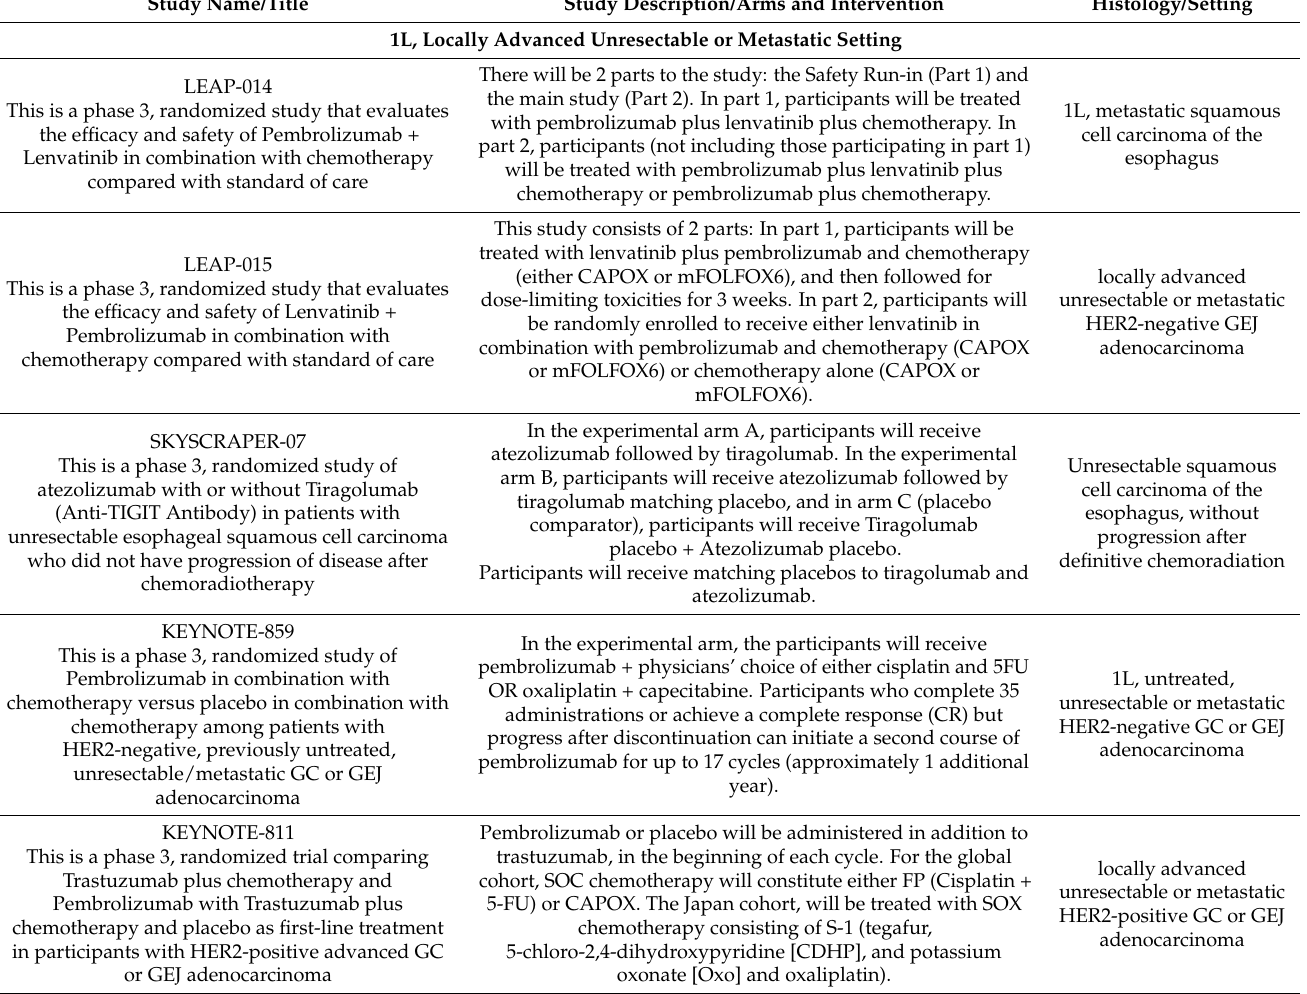
Table 2. Notable ongoing phases 2 and 3 studies for the first-line treatment of gastro-esophageal cancer (GEC) both in the metastatic and peri-operative settings. The contents of this table are retrieved from clinicaltrials.gov (1L: first-line; CAPOX: capecitabine/oxaliplatin; FOLFOX: 5-fluorouracil/oxaliplatin; SOC: standard of care; GEJ: gastro-esophageal junction; GC: gastric cancer; XP: capecitabine/cisplatin; FP: